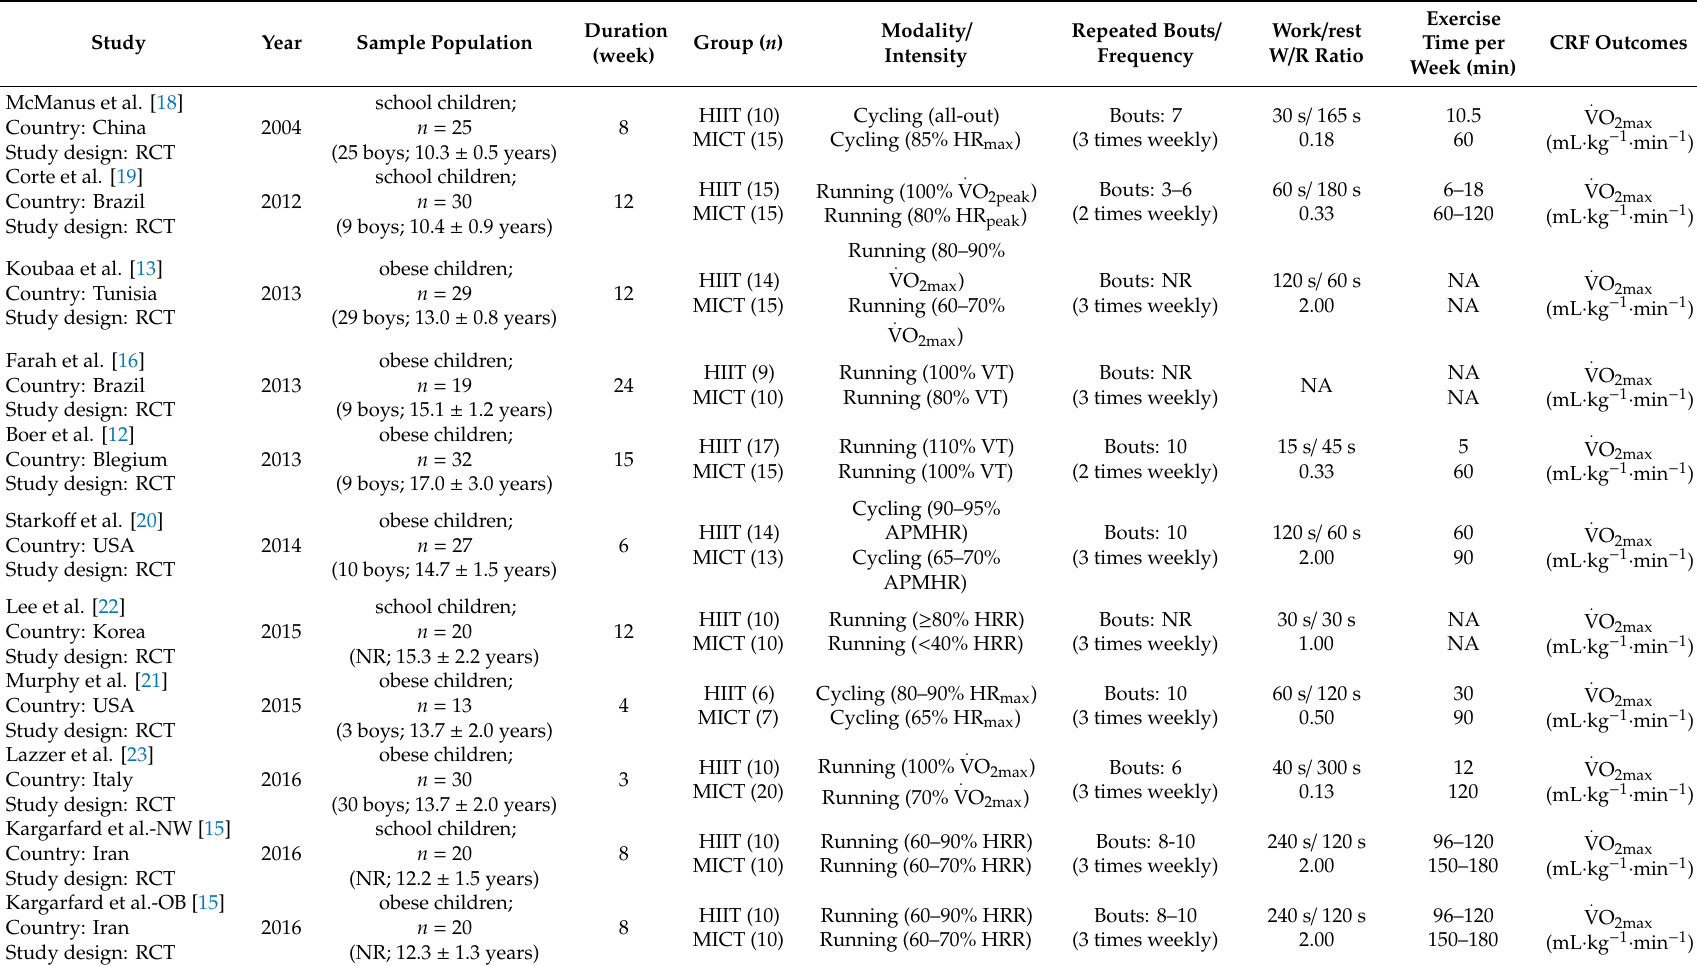
Table 1. Characteristics of 18 included studies examining the e ff ect of high-intensity interval training on cardiorespiratory